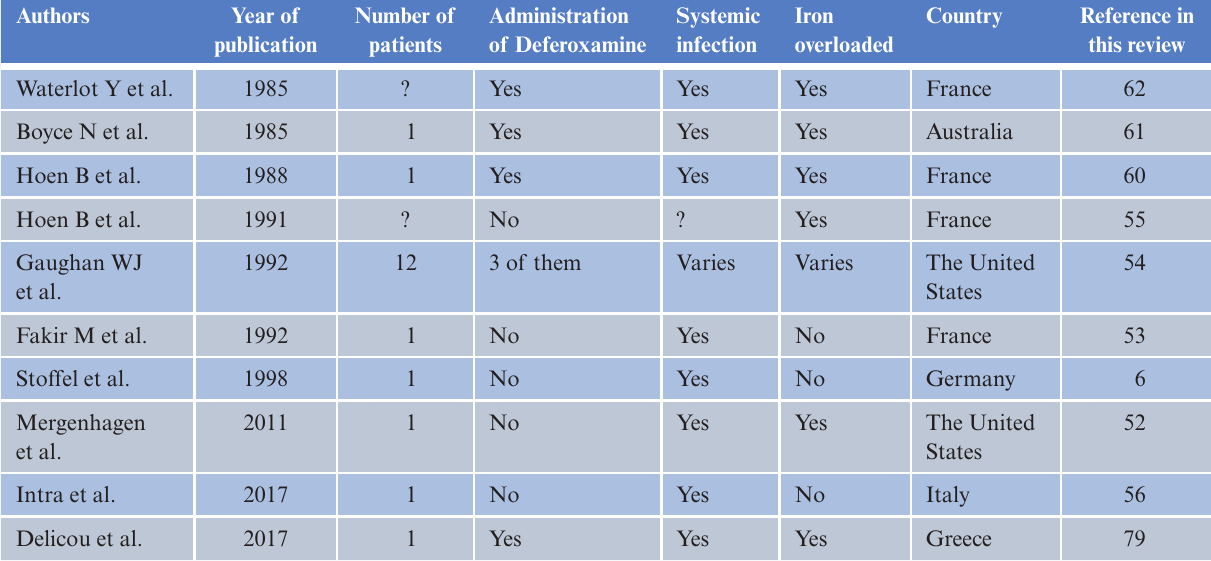
Table 1: Summary of reported yersinia enterocolitica infection in hemodialysis patients.